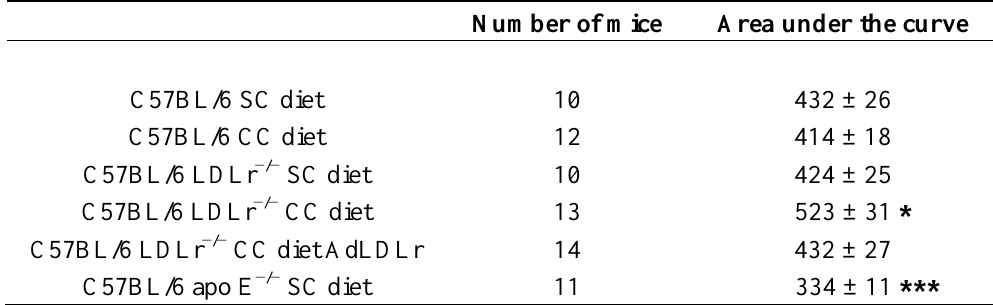
523 ± 31 * C57BL/6 LDLr −/− CC diet AdLDLr 14 432 ± 27 C57BL/6 apo E −/− SC diet 11 334 ± 11 *** Data are expressed as means ± SEM. SC: standard chow. CC: 0.2% cholesterol 10% coconut oil. * p <